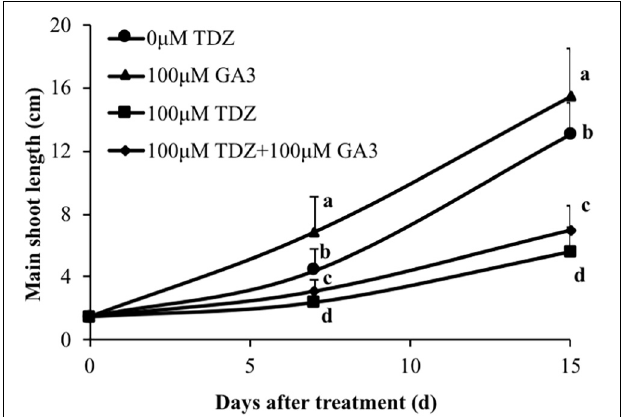
FIGURE 10 | Effects of 100 µ M TDZ and GA 3 spray treatments on the main shoot length of potted miniature rose plants after 1 and 2 weeks. Means ( ± SE, n = 16) within days with different letters are significantly different at P ≤ 0.05.